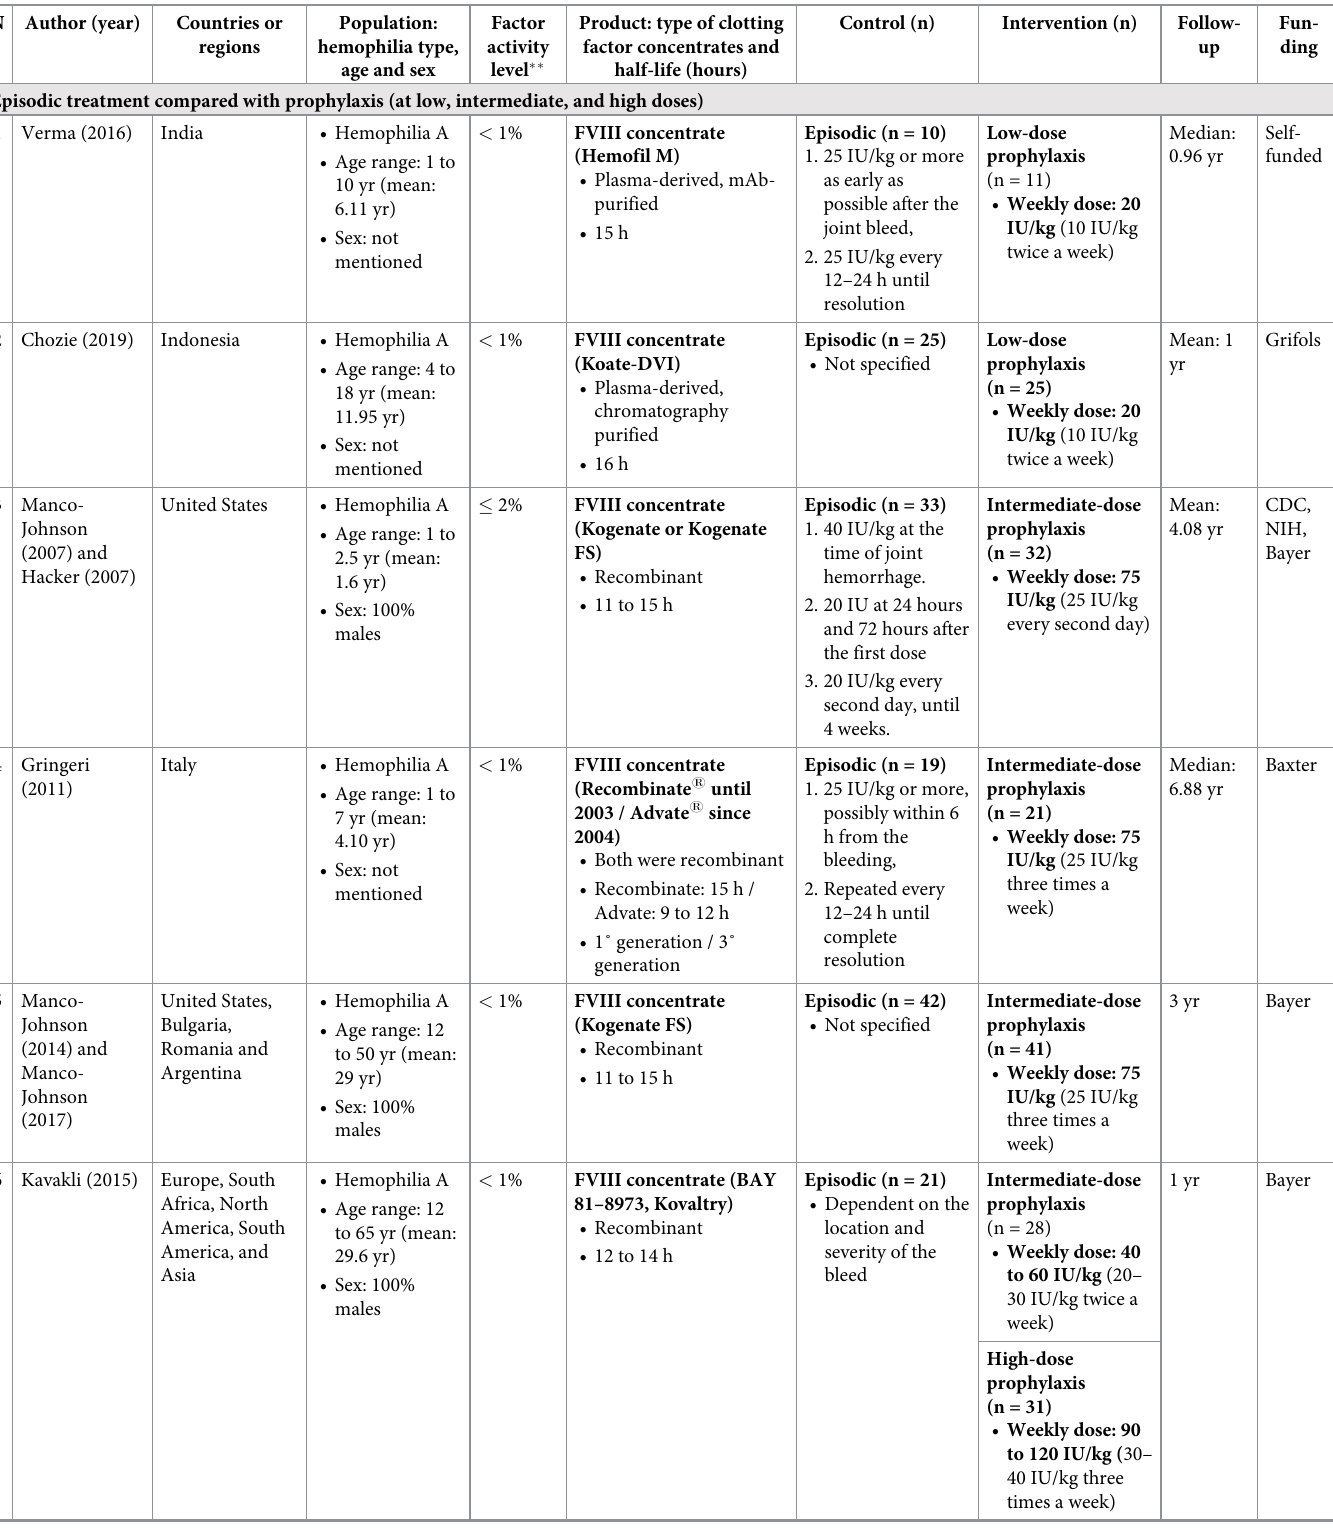
Table 1. Study and participants’ characteristics in the included